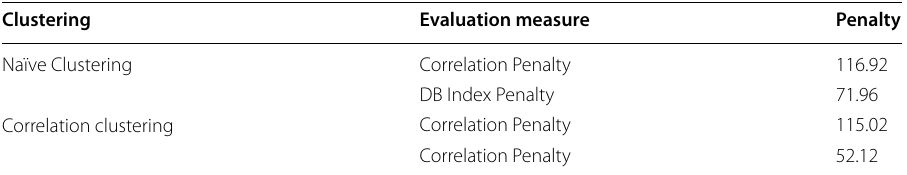
Table 5 Penalty evaluation for naive and correlation clustering